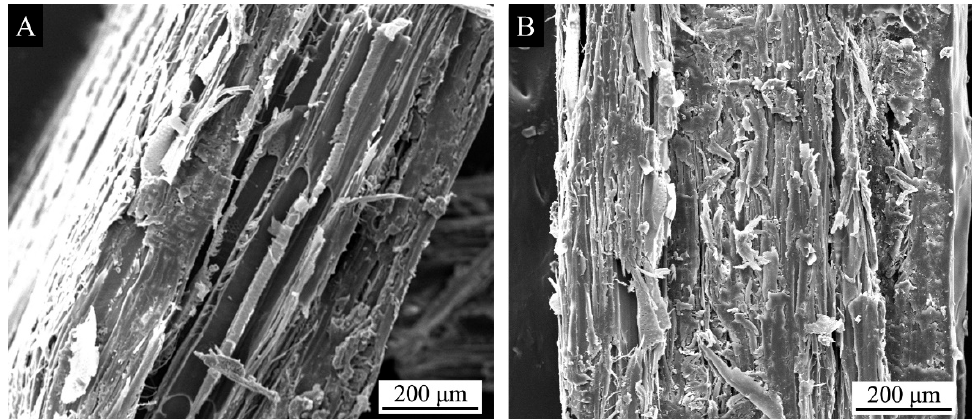
Figure 5. Side SEM of F. mandshurica veneer after reactive red dyeing at different concentrations of ( A ) 0.5% and ( B ) 3.0%.